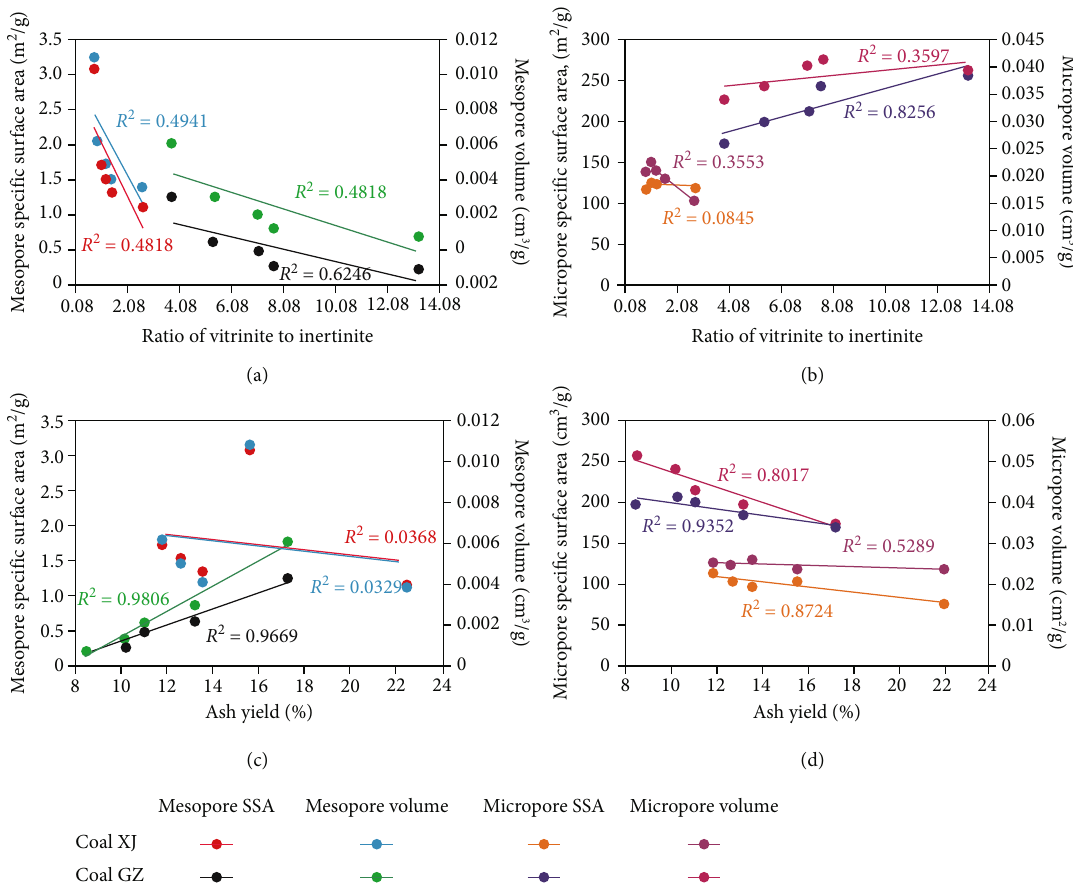
Figure 11: Scatter plots and linear regressions of the ratio of vitrinite to inertinite (a, b) and ash yield (c, d) versus mesopore characteristics and micropore characteristics of Coal XJ and Coal